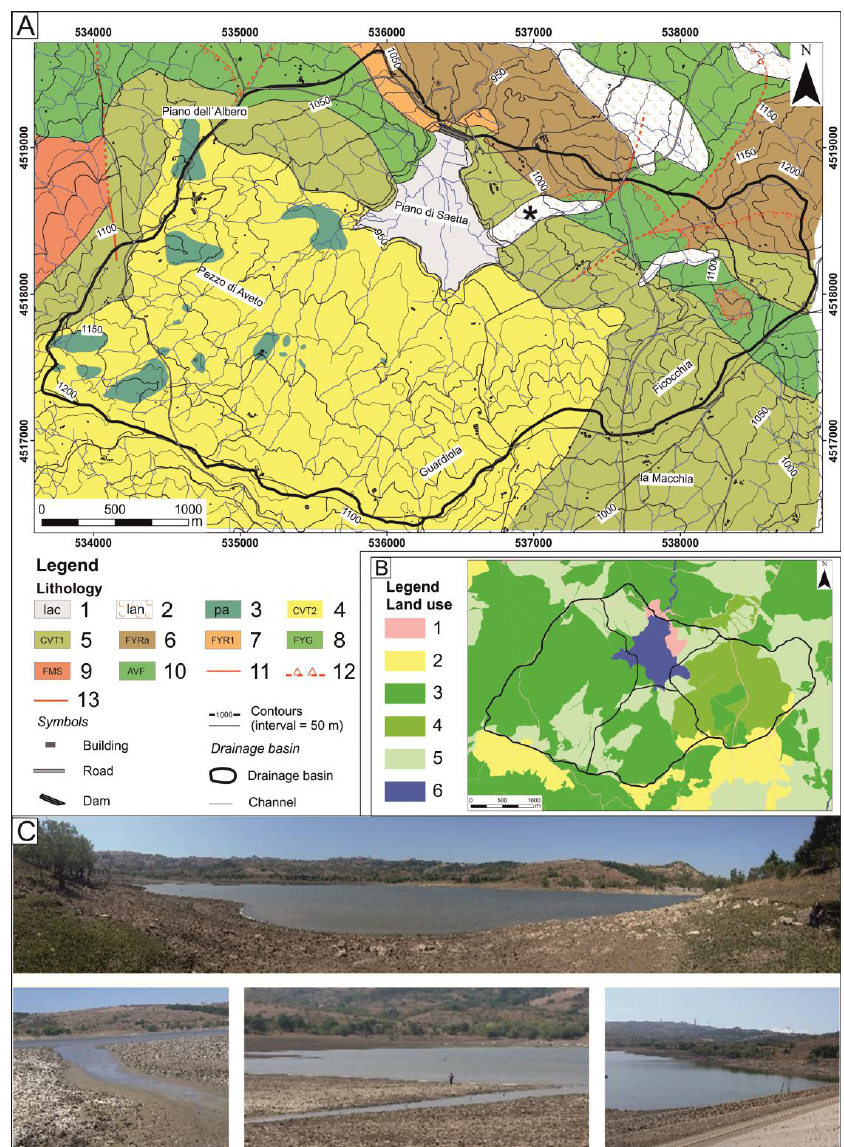
Figure 2. Physical features of the study area. ( A ) Geological map of the study area (modified from [47]). Legend: (1) Fine-grained sediments of lacustrine environment (lac, Holocene) (2) Landslide deposits (lan, Holocene) (3) Decametric blocks of mudstone (pa, Upper Miocene); (4) Silt and marly clay (CVT2, Upper Miocene); (5) Coarse- to medium-grained light brown sandstone with rare intercalation of 1 to 6 thick lens of polygenic conglomerate (CVT1, Upper Miocene); (6) Calcareous breccia and grey shale (FYRa, Lower Cretaceous-Oligocene); (7) Chert, marly clay with intercalation of calcarenites and calcareous breccia (FYR1, Lower Cretaceous-Oligocene); (8) Light-grey and greenish shale with intercalation of thin beds of marls and marly limestone (FYG, Lower Cretaceous); (9) Alternance of calcarenite, calcilutite with nodular chert and varicoloured clay (FMS, Upper Cretaceous-Eocene); (10) Varicoloured clay (AVF, Lower Cretaceous); (11) High-angle fault (dashed if uncertain); (12) Thrust (dashed if uncertain); (13) Stratigraphic contact. The asterisk highlights a landslide representing a probable key-element in reservoir sediment flux. ( B ) Land use map. Legend: (1) Anthropic surfaces and roads; (2) Arable lands; (3) Sclerophyllous vegetation; (4) Broad-leaved and mixed forests; (5) Natural grasslands; (6) Water courses and water bodies. ( C ) Panoramic views showing the artificial reservoir and the surrounding